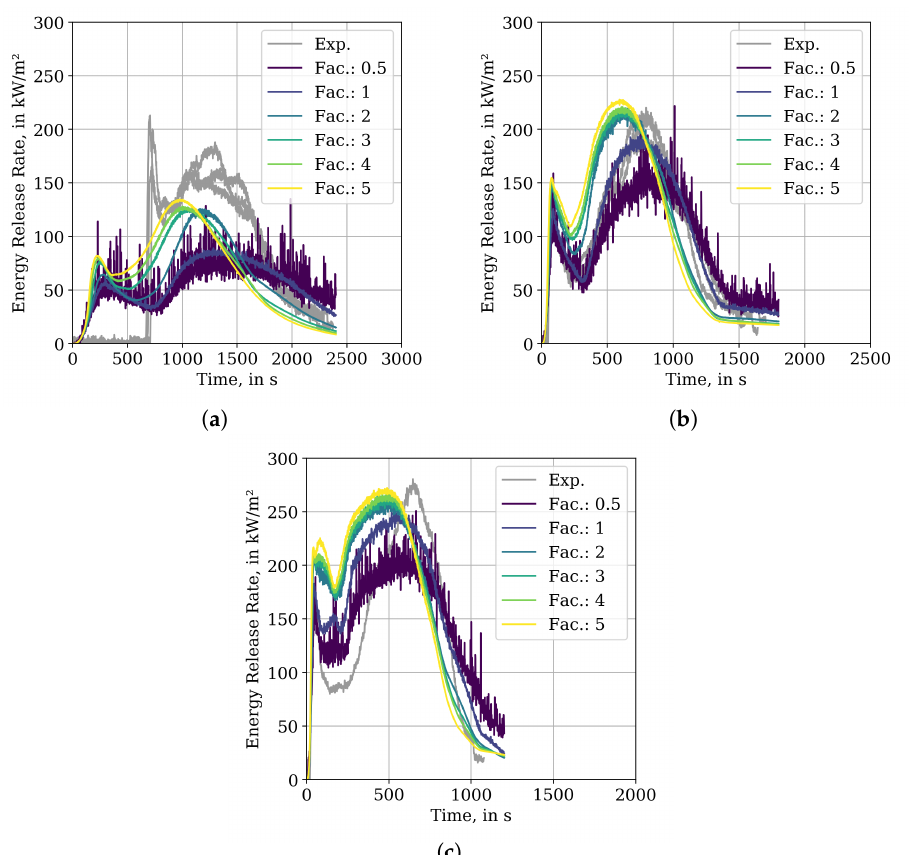
Figure A5. Comparison between energy release rates of Cone Calorimeter data, from simulation and experiment (Exp.). Fluid cell sizes were changed by the noted factor, w.r.t SCC (47 mm). The used material parameter set is taken from IMP T b . ( a ) Incident heat flux of 25 kW/m 2 . ( b ) Incident heat flux of 50 kW/m 2 . ( c ) Incident heat flux of 75 kW/m 2 .